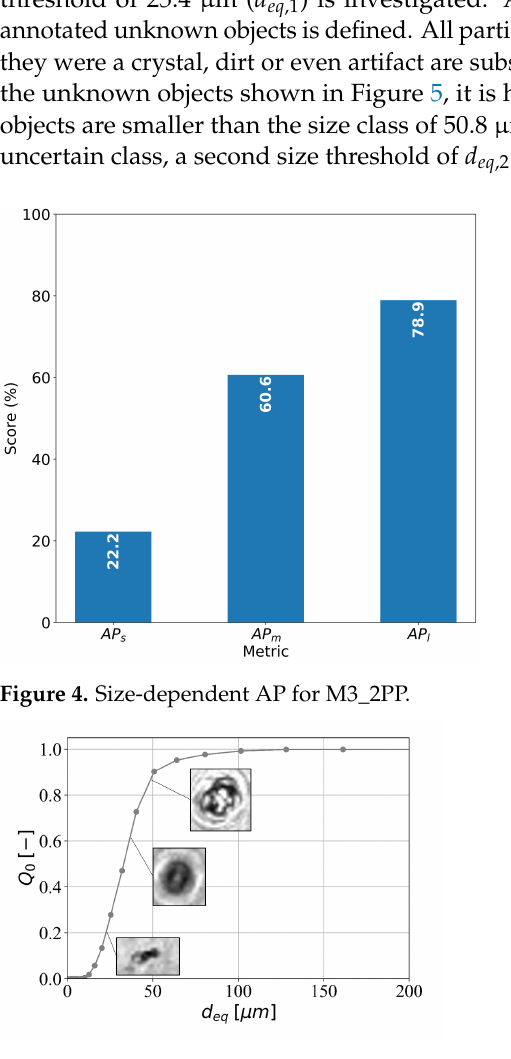
Figure 5. Class unknown (644 labeled objects): example images and size